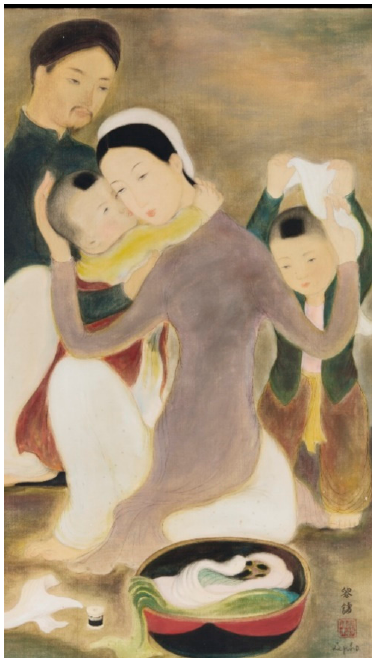
Figure A18. Gia dinh —Le Pho. Auctioned at Sotheby’s, September 2017. The images were sourced from Tuoi Tre Newspaper (Thuy 2017).